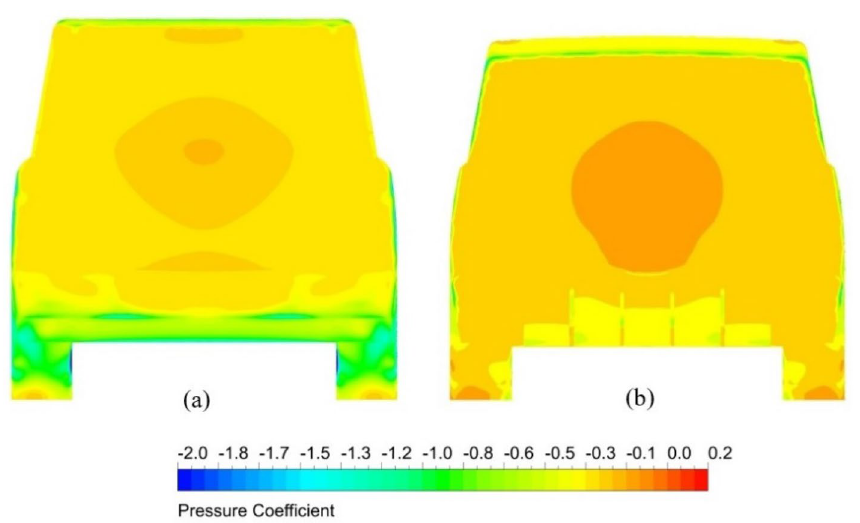
Figure 16. Back view of surface pressure distribution for two models of the LRD4: ( a ) the benchmark and ( b ) the modified model with diffuser and spare